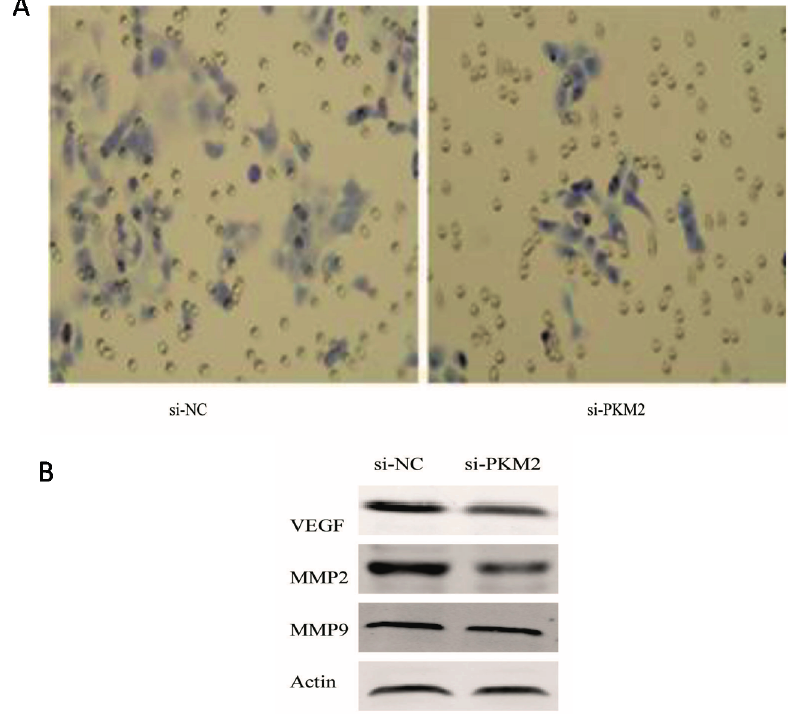
Figure 6. The functional role of PKM2 in invasion of A549 in vitro . ( A ) A549 cells transfected with si- PKM2 were examined for their invasive capability. At 72 h post-transfection, the number of migrating cells was significantly decreased compared with the control cells (magnification, ×200); ( B ) Effects of PKM2 knockdown on the expression of VEGF (vascular endothelial growth factor), MMP-2 and MMP-9 at 72 h